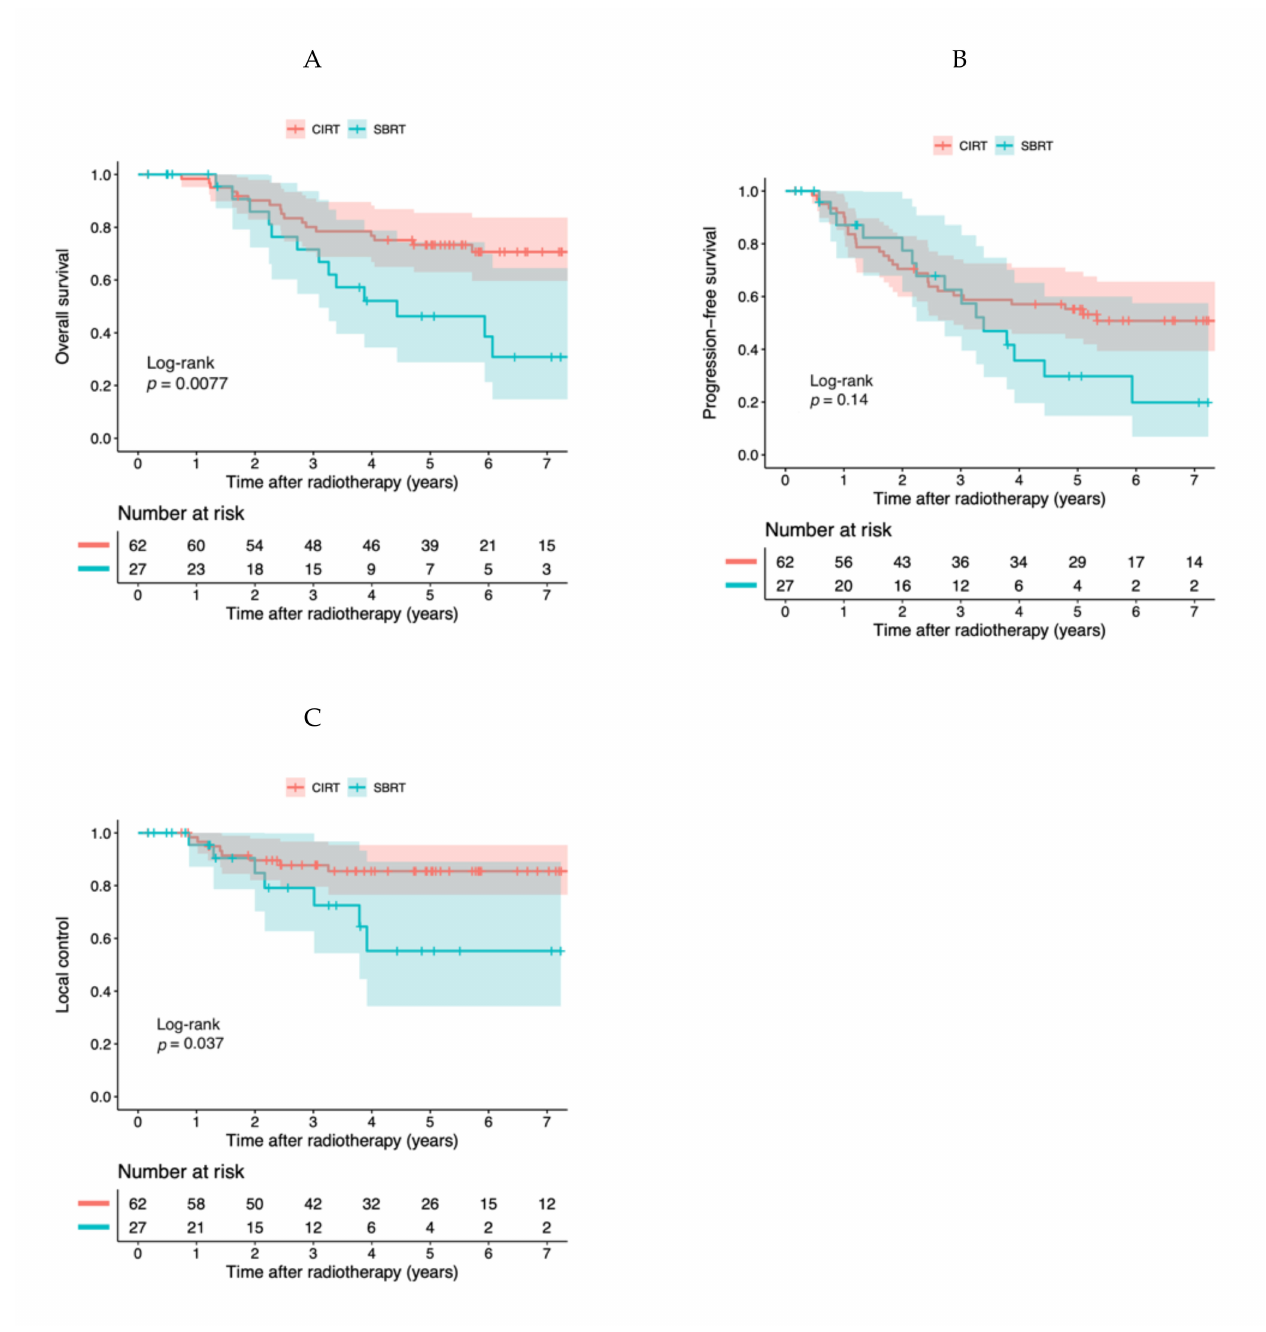
Figure 1. Kaplan–Meier curves for the entire cohort ( n = 89). ( A ) Overall survival, ( B ) progression-free survival, and ( C ) local control. Colored regions show 95% confidence